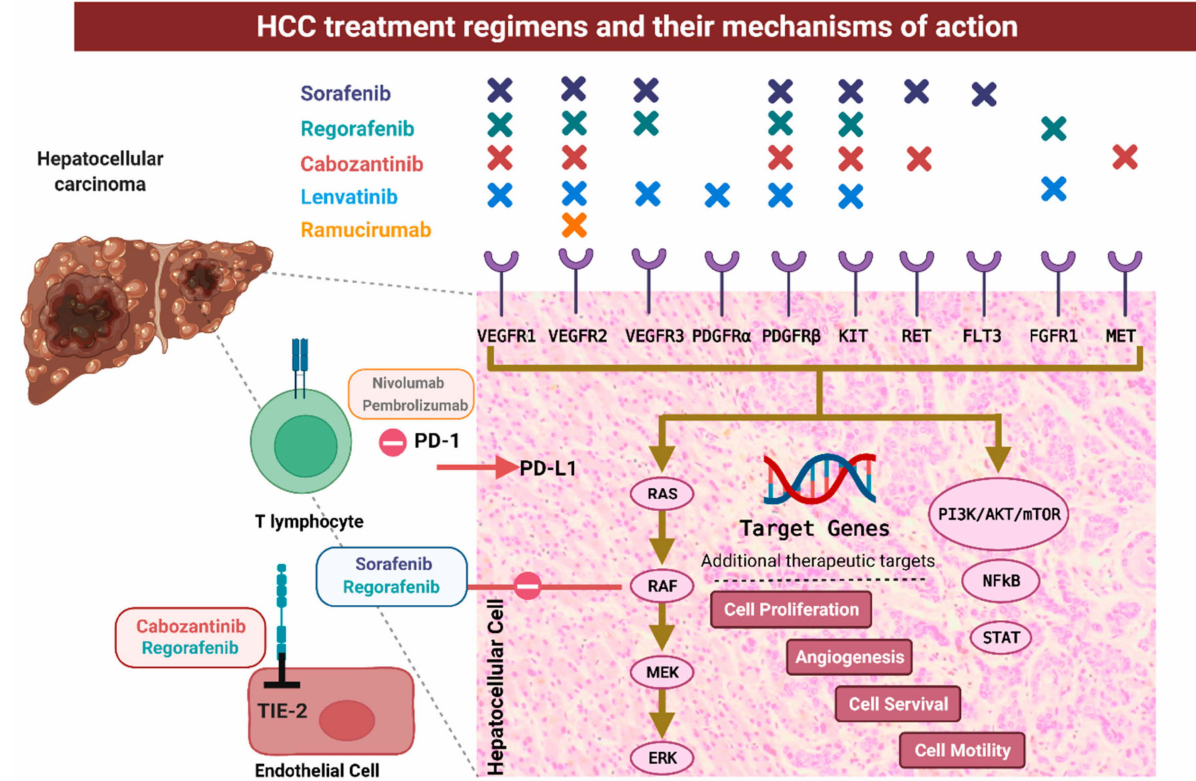
Figure 4. Methods of treatment and the mechanisms through which they function. When upstream signaling molecules are genetically altered, the Ras/Raf, MEK, ERK, and PI3K/Akt/mTOR pathways can be activated. Abbreviations: HCC, hepatocellular carcinoma; VEGFR, vascular endothelial growth factor receptor 2; PDGFR, platelet-derived growth factor; FLT3, FMS-like tyrosine kinase 3; PD-L1, programmed death ligand 1; FGFR, fibroblast growth factor receptors; hepatocyte growth factor receptor (HGFR); Tie2, a tyrosine kinase receptor; PD-1, programmed cell death protein; MET, tyrosine-protein kinase